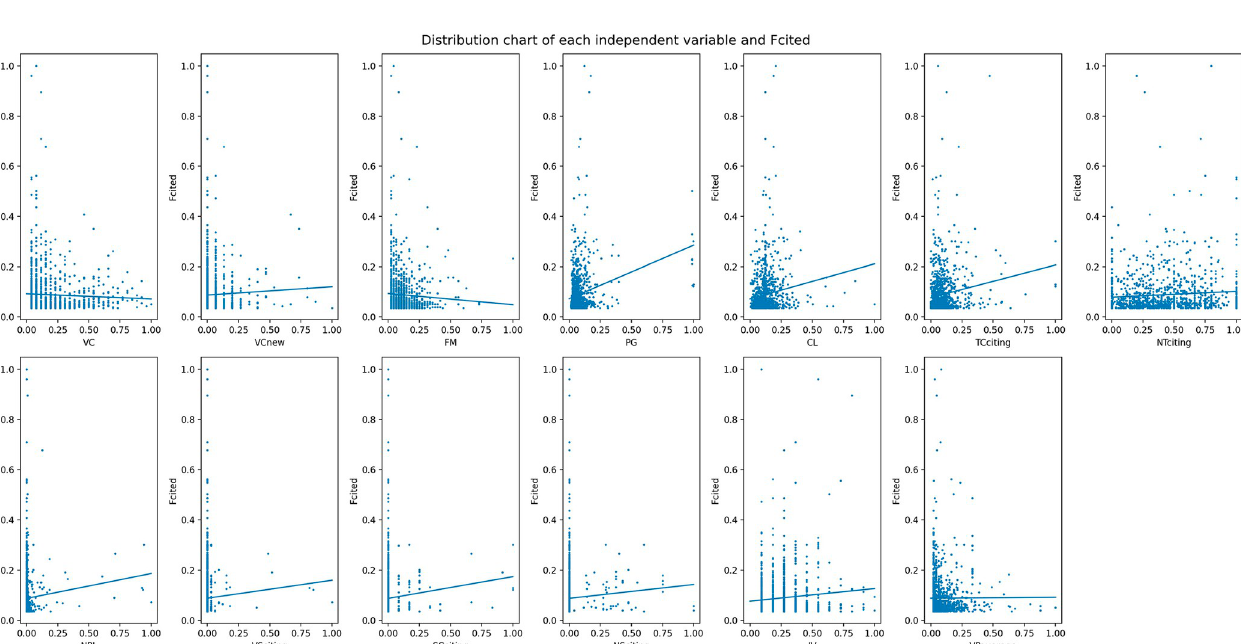
(PN) of the patents, Columns 2 to 14 are 13 explanatory variables used as input data for are the output data for the machine learning models.